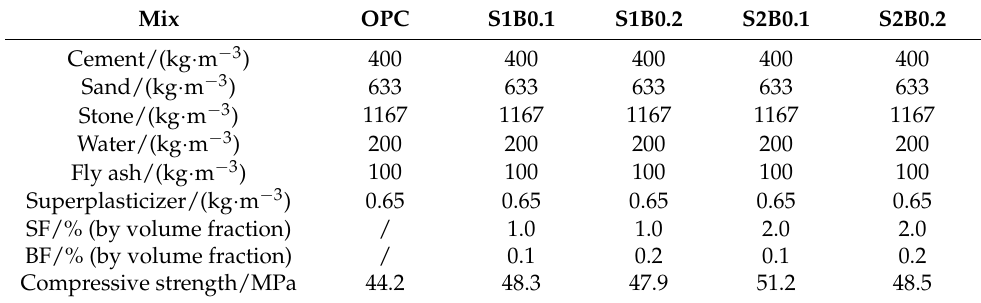
Table 3. Fiber concrete mix